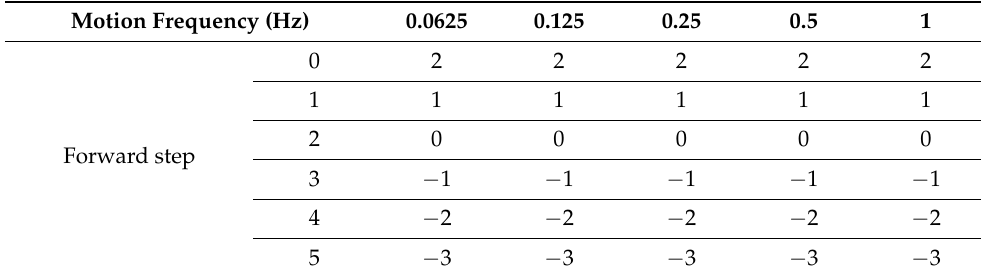
Table 5. Phase deviation with different numbers of prediction steps ( ω s = 100